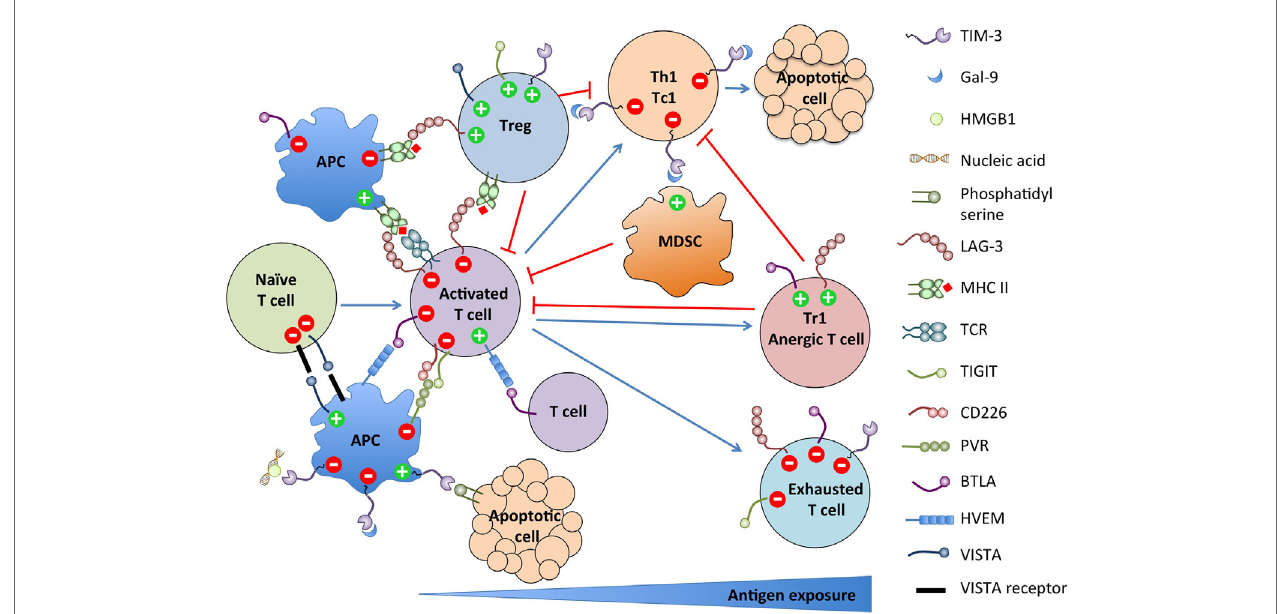
FiGURe 1 | Summary of NCRs expression on immune cell populations and their